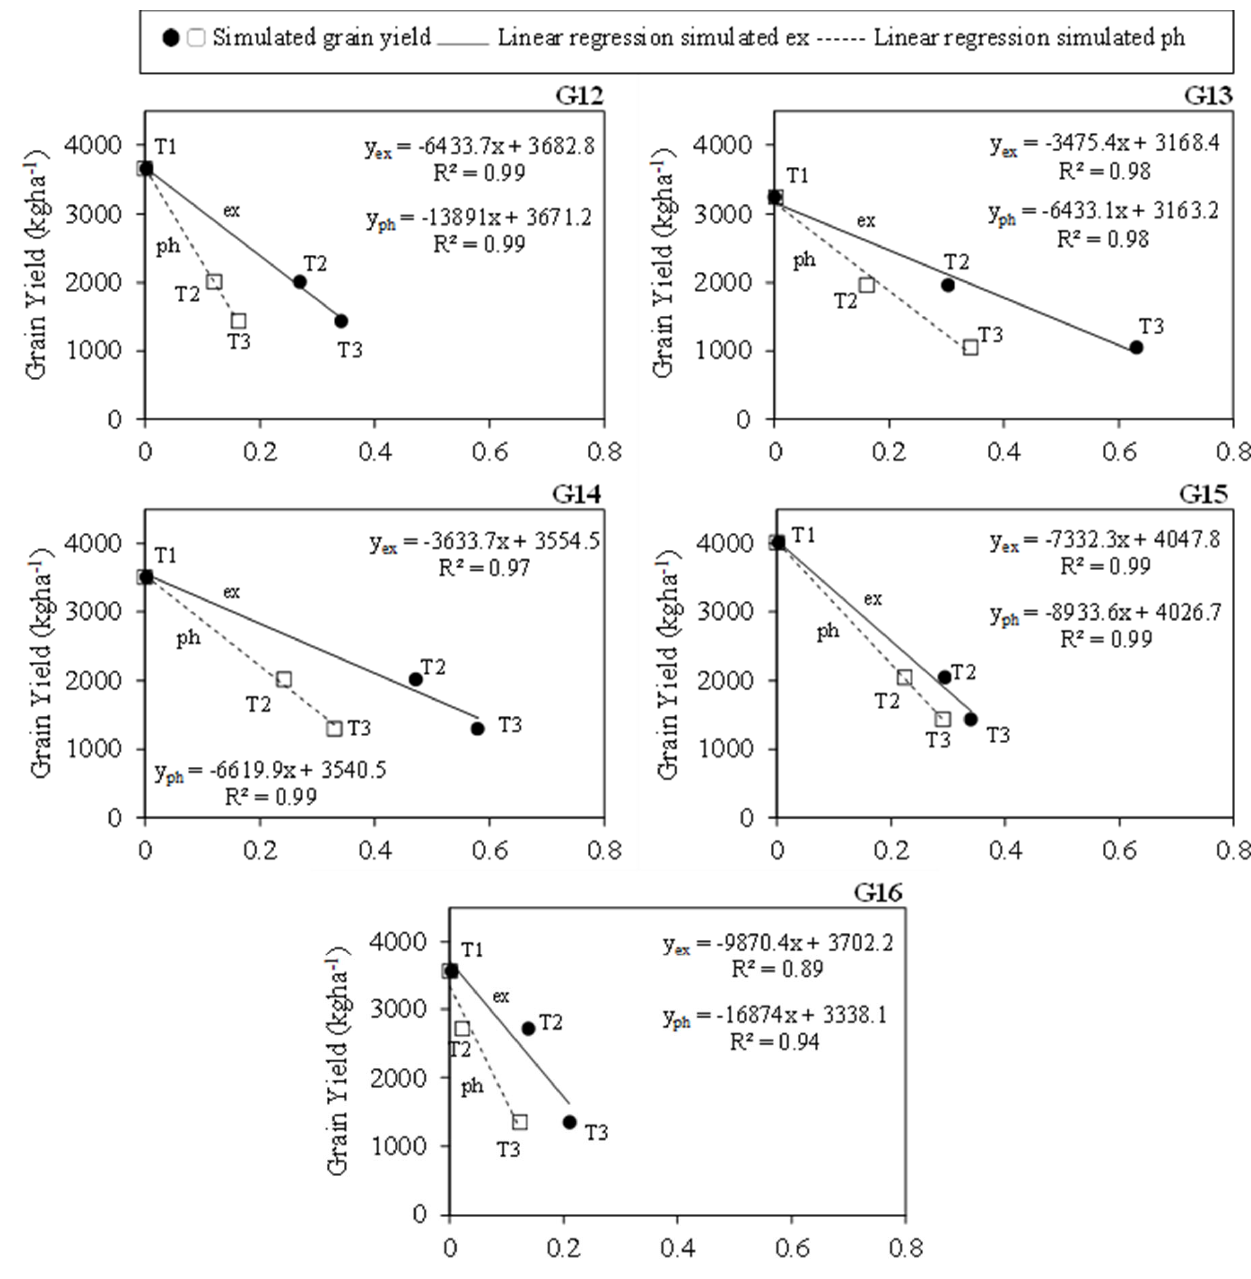
Figure 10. Linear regression relationship between the simulated grain yield and average drought stress for photosynthesis (ph) and between the simulated grain yield and average drought stress for growth expansion (ex) for genotypes G12–G16 in group B under T1: control (100% FC), T2: moderate stress (70% FC), and T3: severe stress (50% FC) treatments in the yield assessment experiment.